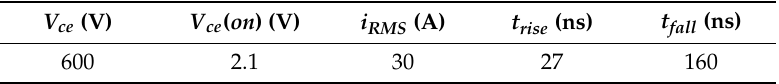
Table 5. Technical specifications of STGW30NC60KD IGBT.